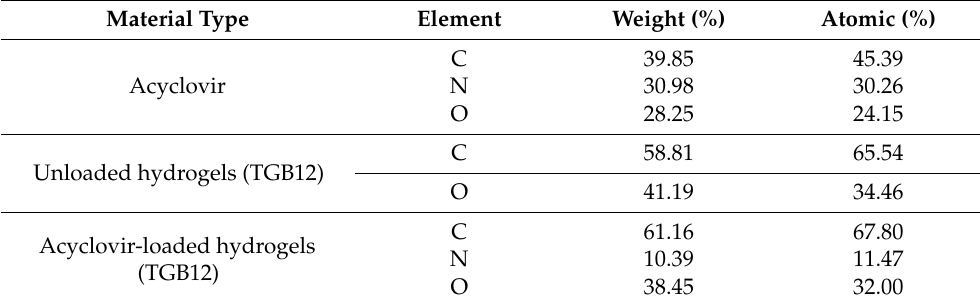
Table 1. Elemental composition of acyclovir-loaded and -unloaded formulations. Material